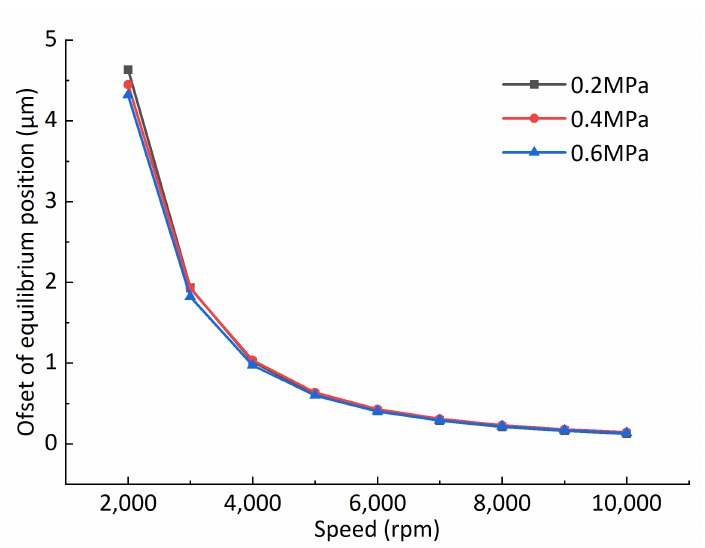
Figure 8. Offset of rotor equilibrium position under different pressures and